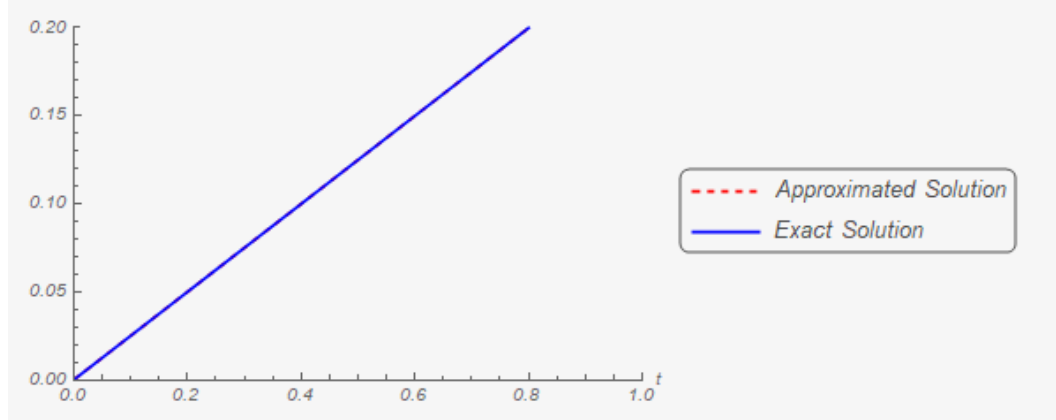
Figure 16. The second component of the exact solution and its three hundred and sixty-fourth